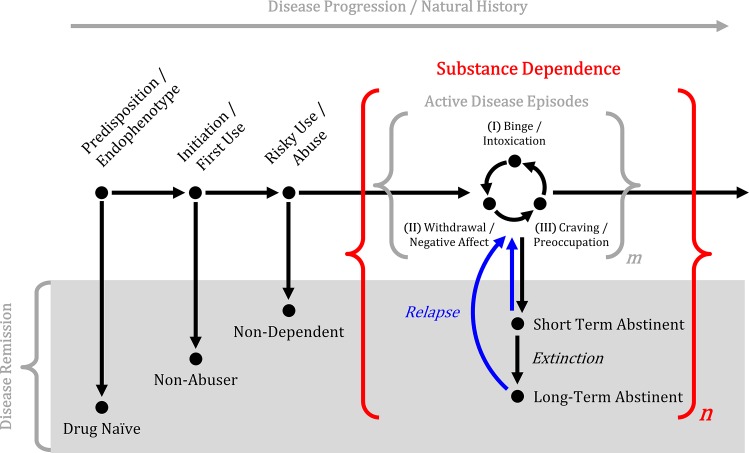
Simplified illustration of the natural history of substance use disorders.Active substance dependence is characterized by sequential stages of binge/intoxication, withdrawal/negative affect, and craving/preoccupation [13] that repeat a variable number of cycles, represented by m. Active disease episodes may be interrupted by periods of short- or long-term abstinence, represented by n.